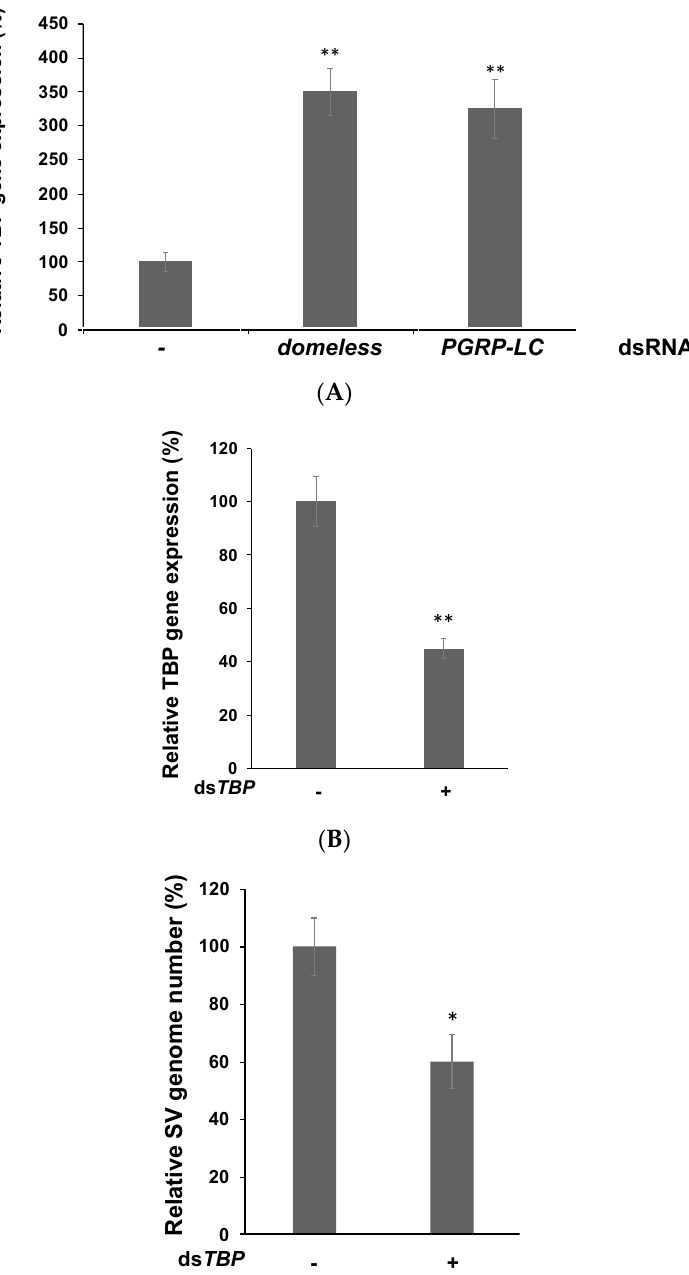
Figure 5. Gene expression of TATA-binding protein (TBP) increased after knocking down domeless and PGRP-LC upstream immune genes. ( A ) TBP expression increased after knocking down domeless and PGRP-LC. We set the untreated group as 100% expression. ( B ) TBP expression decreased with ds TBP transfected S2 cells at 2 dpt. ( C ) The RT-qPCR analysis of sigma virus copies in sigma-virus-infected TBP -knockdown and wild-type cells. Control treated cells were set to 100%. Mean and SD shown; ** p < 0.005; * p < 0.05; one-sample t -test. All experiments were performed with three replicates.